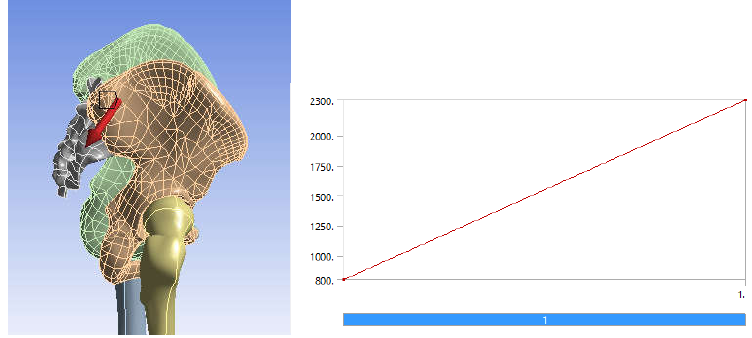
Table 1. Physico-mechanical characteristics of the materials used in the simulation.